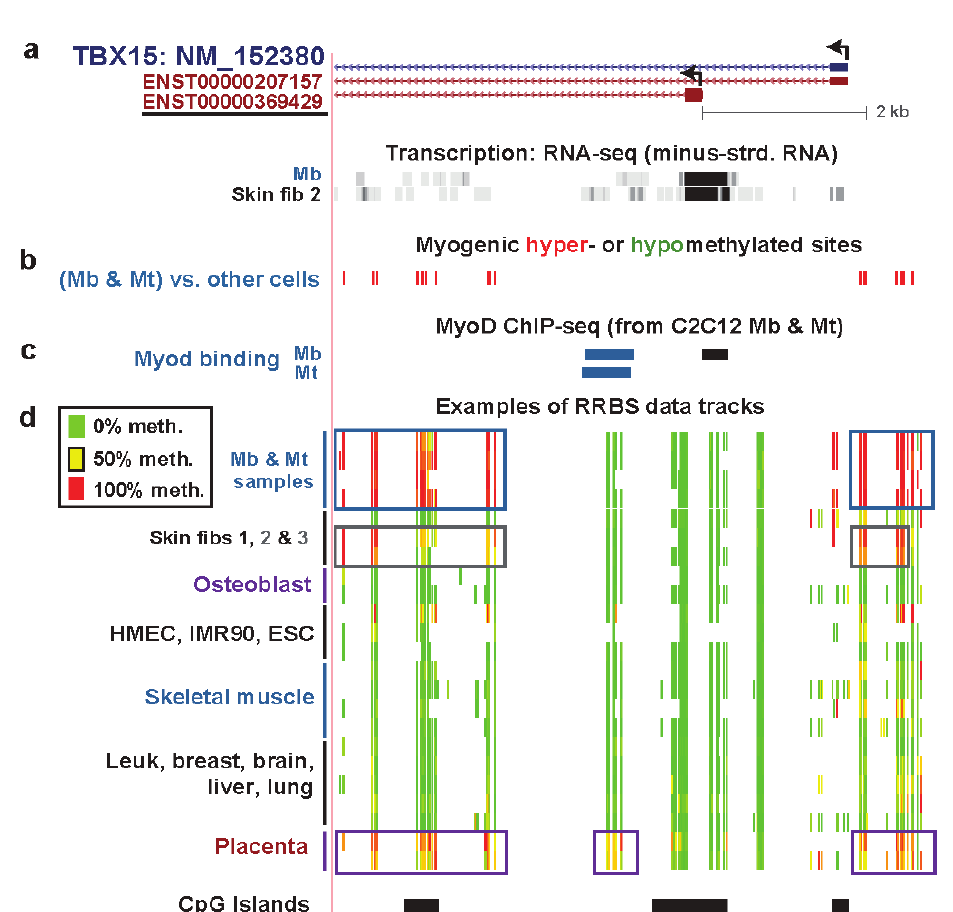
Figure 3. TBX15 , preferentially expressed in myogenic cells: Myogenic hypermethylation immediately upstream and downstream of the empirically observed TSS. ( a ) Minus-strand RNA-seq data for Mb and foreskin fibroblasts are shown aligned under the single RefSeq gene isoform and two ENSEMBL isoforms. The underlined ENSEMBL isoform most closely resembles the observed RNA-seq signal from the minus-strand in Mb and foreskin fibroblasts. In this region (chr1:119525932-119533279), no specific signal was seen for the plus-strand (vertical viewing range, 1-to-10). The much lower expression of TBX15 in HMEC, ESC, HUVEC, NHEK, NHLF, and LCL cell cultures is shown in Figure S3 and Table S1. Very high expression in the osteoblast sample (Ost) is indicated by the H3K79me2 signal shown in Figure S4. ( b ) MbMt-hypermethylated CpG sites (red) or hypomethylated sites (green, none). There were no muscle-hypermethylated or hypomethylated sites in this region. ( c ) MyoD binding from C2C12 ChIP-seq [54] and identification of orthologous human sequences. Sites shown in blue overlapped variants of the MyoD consensus sequence (CAGCTG, V$MYOD_01, V$MYOD_Q6, or E47 sites from Conserved TFBS [29]). ( d ) Examples of RRBS data and the positions of CGIs as in Figure 2. Technical duplicates are shown for the osteoblast, placenta, and two different skeletal muscle samples. The gray box indicates the hypermethylation in the two foreskin fibroblast samples (Skin fibs 2 and 3) that was not present in the fibroblasts from the skin of a 10-year-old girl (Skin fib 1). Placental hypermethylated sites and MbMt-hypermethylated sites are also indicated with